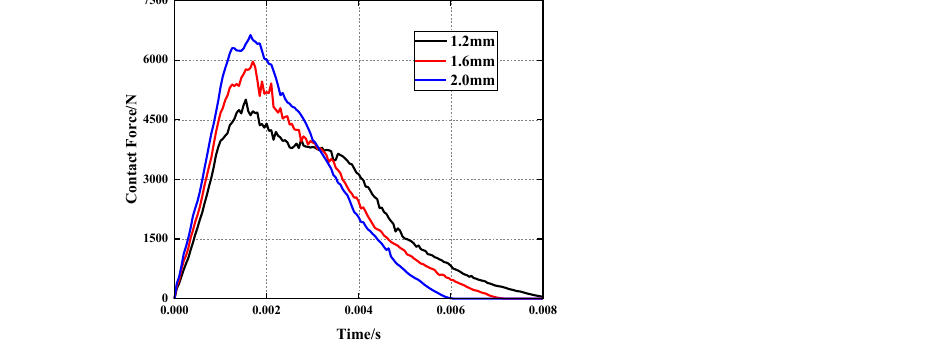
stiffness and impact resistance would be compromised.